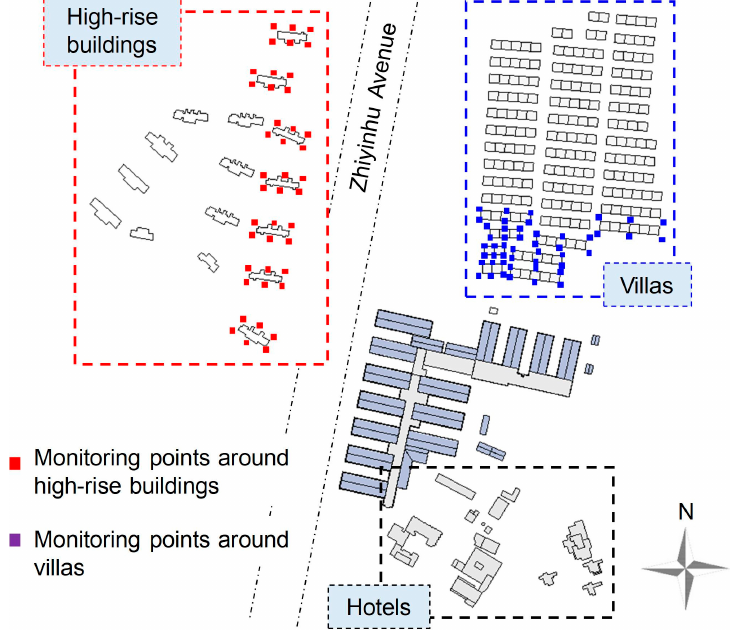
Figure 20. Buildings surrounding the Wuhan Huoshenshan Hospital and corresponding monitoring points in the FDS model.